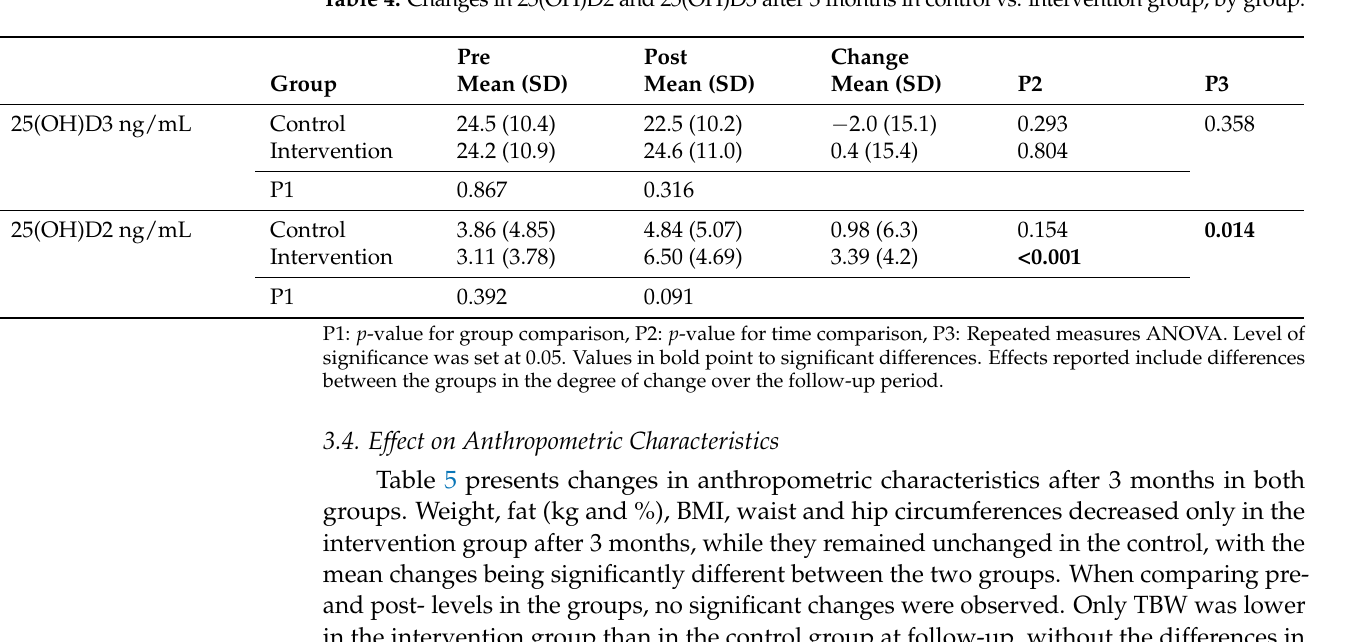
Table 4. Changes in 25(OH)D2 and 25(OH)D3 after 3 months in control vs. intervention group, by group.